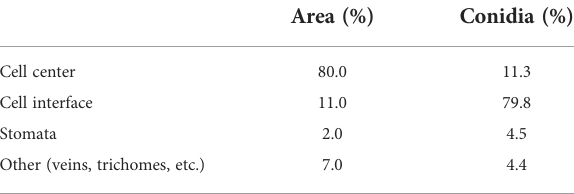
TABLE 1 Conidia distribution on microstructural features.